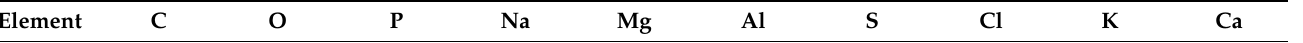
Table 3. Energy dispersive spectroscopy results before and after the biochemical methane potential test.